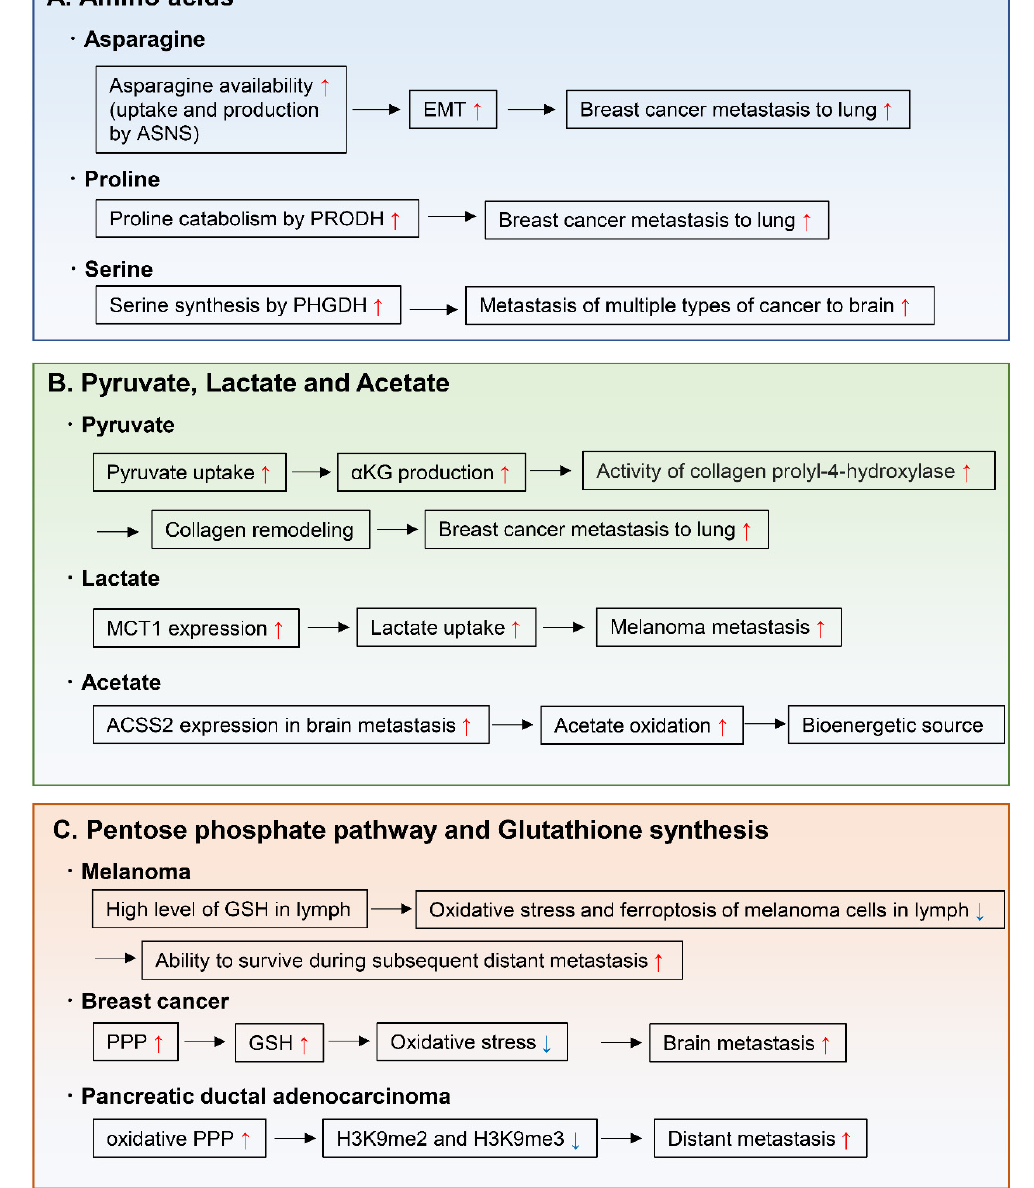
Figure 6. Metabolic reprogramming to form metastatic tumors. The metabolic pathways and enzymes involved in enabling cancer metastasis include those of ( A ) amino acids, ( B ) pyruvate, lactate and acetate, and ( C ) pentose phosphate pathway and glutathione synthesis. ASNS; asparagine synthetase, EMT; epithelial-to-mesenchymal transition, PRODH; proline dehydrogenase, PHGDH; phosphoglycerate dehydrogenase, α KG; α -ketoglutarate, MCT1; monocarboxylate transporter 1, ACSS2; acetyl-CoA synthetase 2, PPP; pentose phosphate pathway, GSH; glutathione-SH.